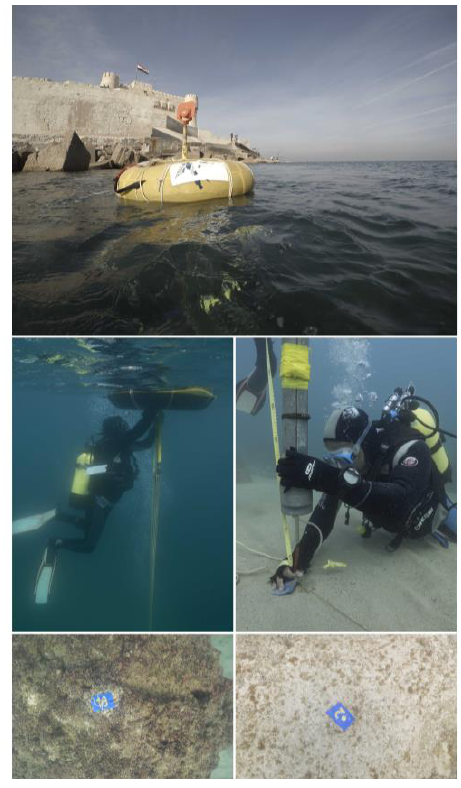
Figure 12. Georeferencing of the DSM ( photography by Philippe Soubias and Mohamed